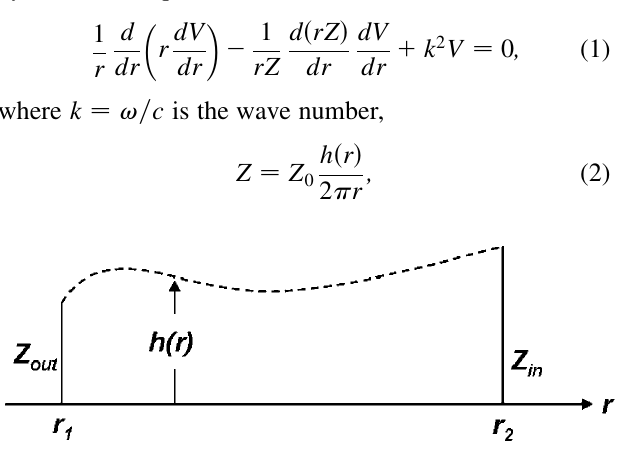
FIG. 2. Schematic of the radial-transmission-line impedance- transformer geometry used by the analytic model. The function h (cid:3) r (cid:4) is the transmission-line gap as a function of r